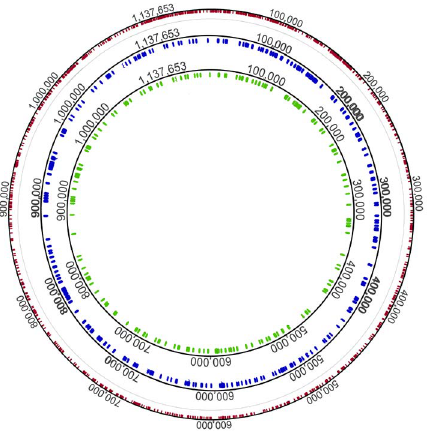
Figure 2. Representation of the Bosnia A chromosome with location of Bosnia A-, TPE-, and TPA-specific sequences. Bosnia A-specific sequences are shown in green while TPE-specific sequences (TPA and Bosnia A sequences are identical in these loci) are shown in blue. TPA-specific sequences (TPE and Bosnia A sequences are identical in these loci) are shown in red. Bosnia A-specific sequences comprised 406 loci (encompassing a total of 2772 bp) while TPE- and TPA-specific sequences were found in 197 (635 bp) and 1422 (2335 bp) loci, respectively. doi:10.1371/journal.pntd.0003261.g002 PLOS Neglected Tropical Diseases |